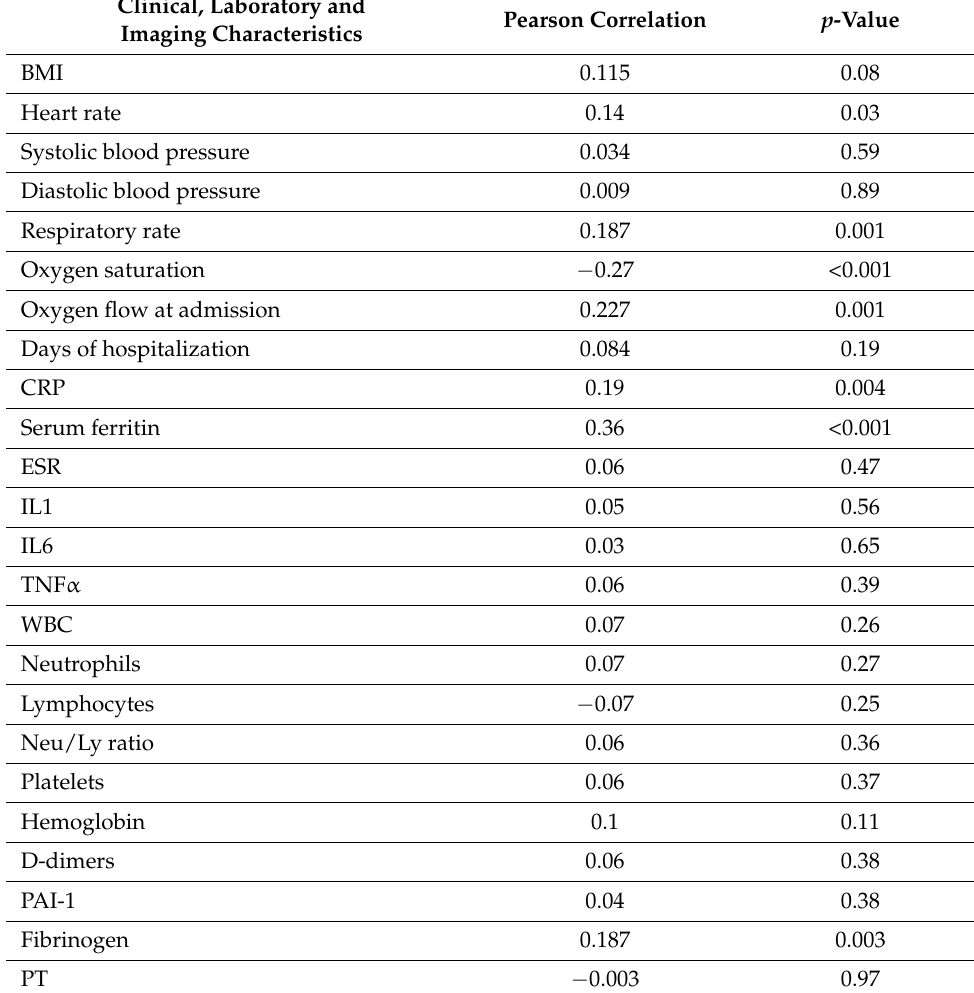
Table 3. Correlations of clinical, laboratory and imaging parameters with liver involvement. Clinical, Laboratory and Imaging